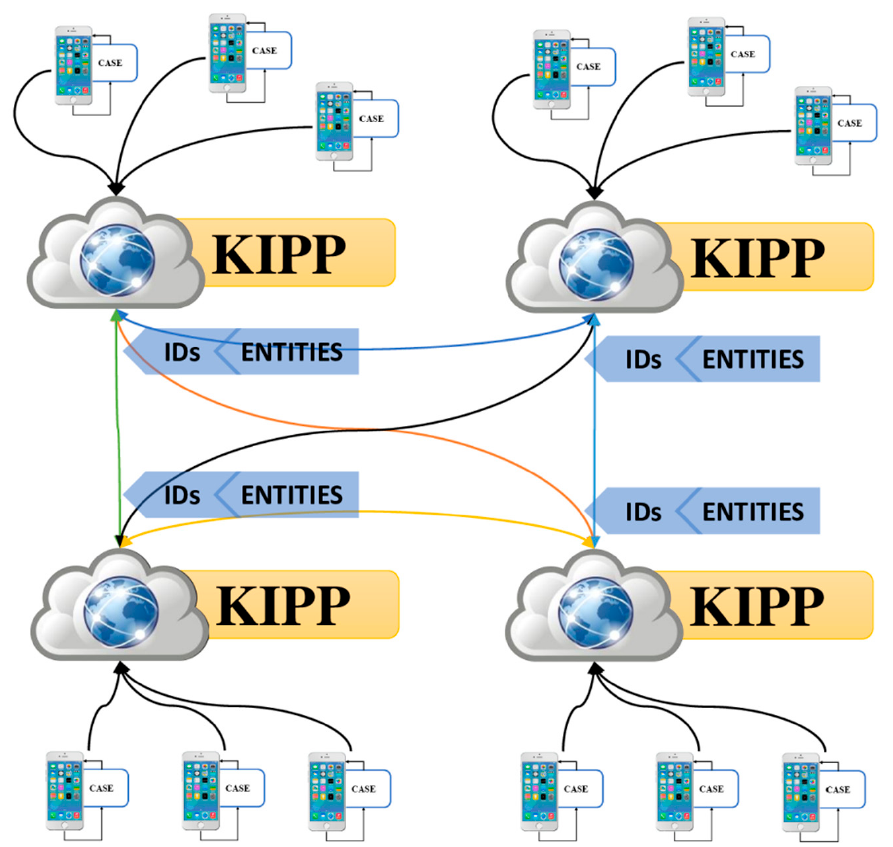
Figure 9. Graphical Representation of a Network of various cloud-level modules to detect the exchange of similar abusive content across a network or organization.